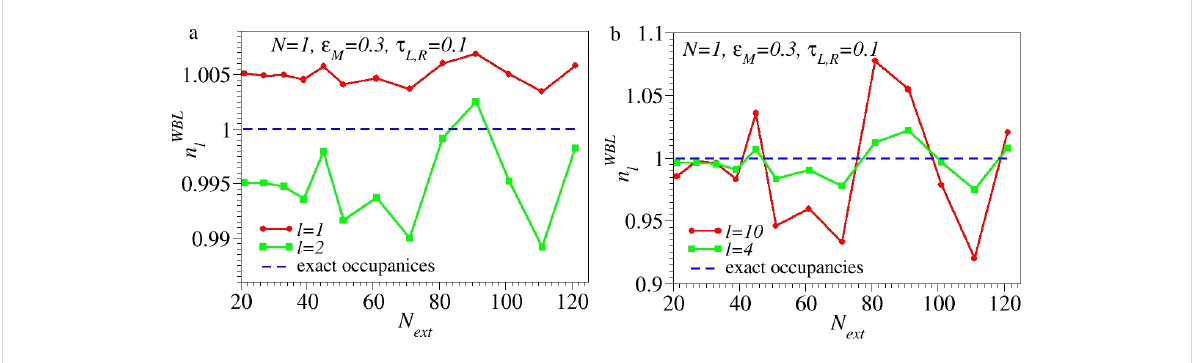
Figure 6: Even when increasing the size, N ext , of the extended molecule well beyond that which current computational facilities that employ NEGF- DFT implementations can handle ( N ext = 121 amounts to 60 electrode “layers” on either side), the occupancies computed within the WBL do not approach the exactly computed values (the exact values represented by the blue horizontal lines differ from 1 by approx. 10 − 5 ). (a) Results for the first ( l = 1) and second ( l = 2) neighboring sites, and (b) fourth ( l = 4) and tenth ( l = 10) neighboring sites within electrodes relative to the “small” mole- cule, modeled as a single site and parameter values as given in Figure